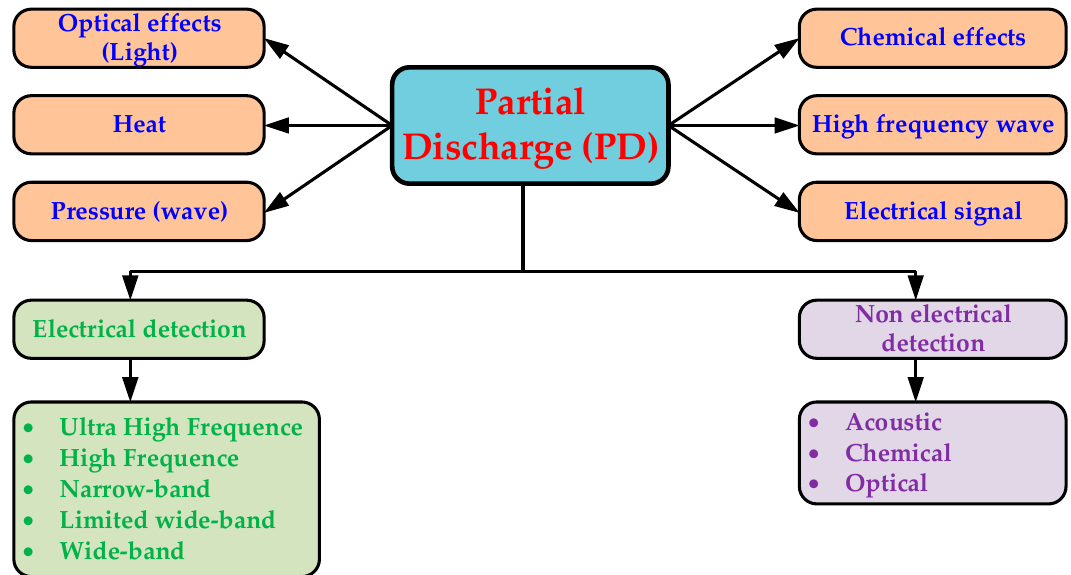
Figure 3. Overview of the physical effects from partial discharge (PD) activities.